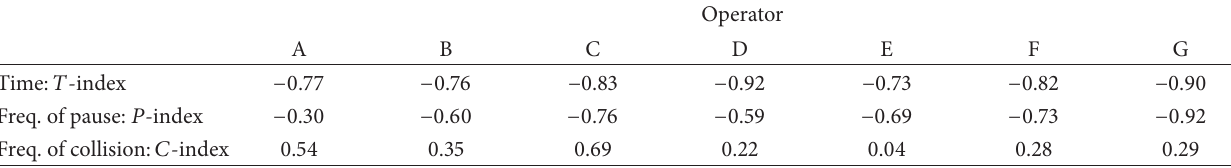
Table 1: Correlation coefficients of 𝑇 -index, 𝑃 -index, and 𝐶 -index, against the number of trials.